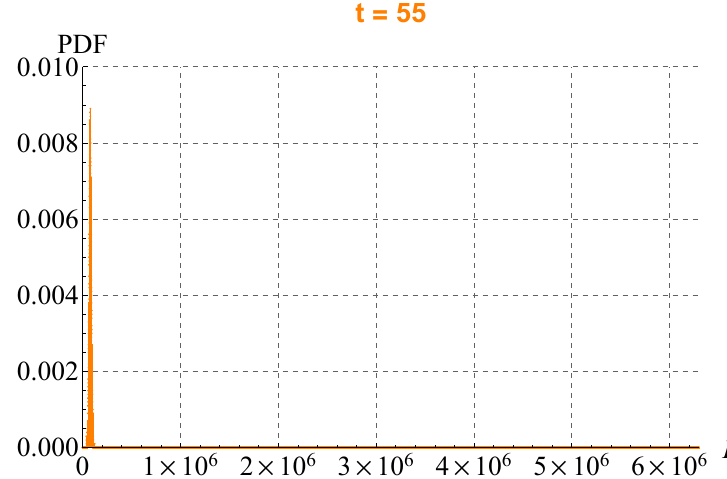
Figure 30. USA-Three-Waves Model. US-PDF at the beginning of the lockdown measures (55 days).